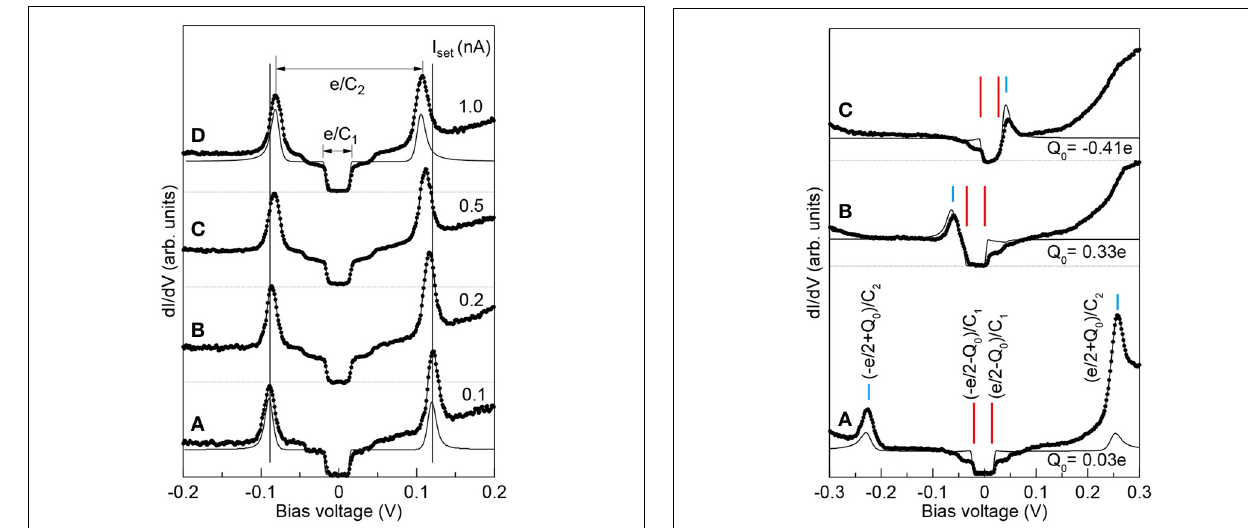
FIGURE 6 | Manipulation of the residual charge Q 0 . dI / dV spectra measured on the same island with 7.9nm side, showing features related to both, C 1 and C 2 , with varying Q 0 , and corresponding simulations. The residual charge ( Q 0 ) of the island is changed by a bias voltage pulse (duration: 50 μ s, current: 1nA). Parameters of the simulation: C 1 = 3 . 8aF, C 2 = 0 . 335aF, R 1 = 25M (cid:3) , R 2 = 2300M (cid:3) ; (A) : Q 0 = 0 . 03 e , (B) : Q 0 = 0 . 33 e , (C) : Q 0 = − 0 . 41 e